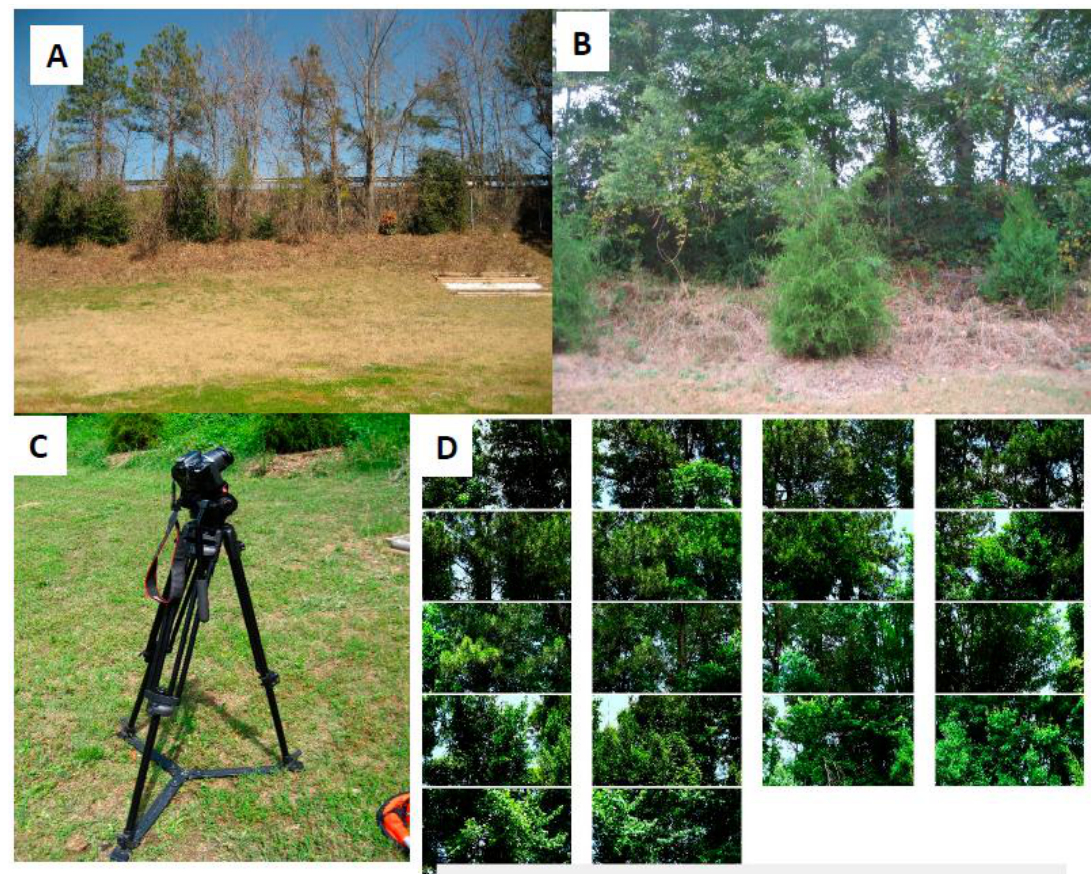
(LAI); (Panel B ) shows the vegetative barrier during a time of higher LAI; (Panel C ) shows the